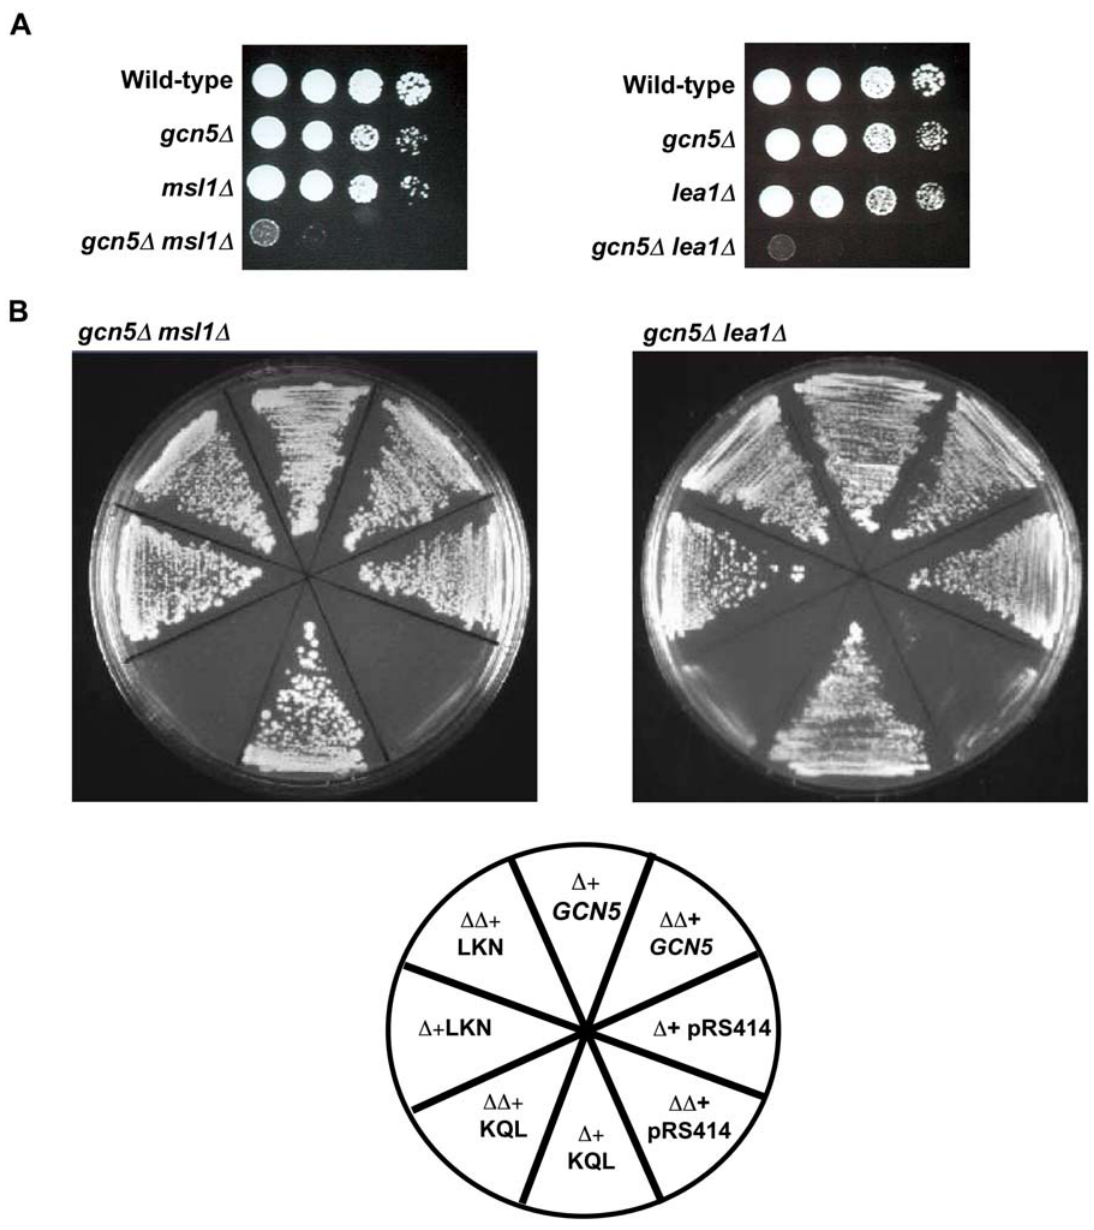
Figure 1. GCN5 interacts with genes encoding the non-essential U2 snRNP proteins, MSL1 and LEA1 . (A) Dilution series of double mutants, gcn5 D msl1 D and gcn5 D lea1 D . Cells were grown at 30 u C in YPD liquid medium until the desired O.D. 600 was obtained. Cells were spotted onto YPD plates as a ten-fold serial dilution, and the plates were incubated at 30 u C for two days. (B) Viability analysis of the double mutants gcn5 D msl1 D and gcn5 D lea1 D in the presence of Gcn5 mutants. Cells were transformed with GCN5 HAT mutants ( TRP plasmids, pRS314) and then streaked onto 5-FOA-TRP to select for the ability to lose the wild-type copy of GCN5 on a URA3 -marked plasmid. Plates were incubated at 30 u C for two days. D indicates deletion of GCN5 ; DD indicates deletion of GCN5 and either MSL1 or LEA1